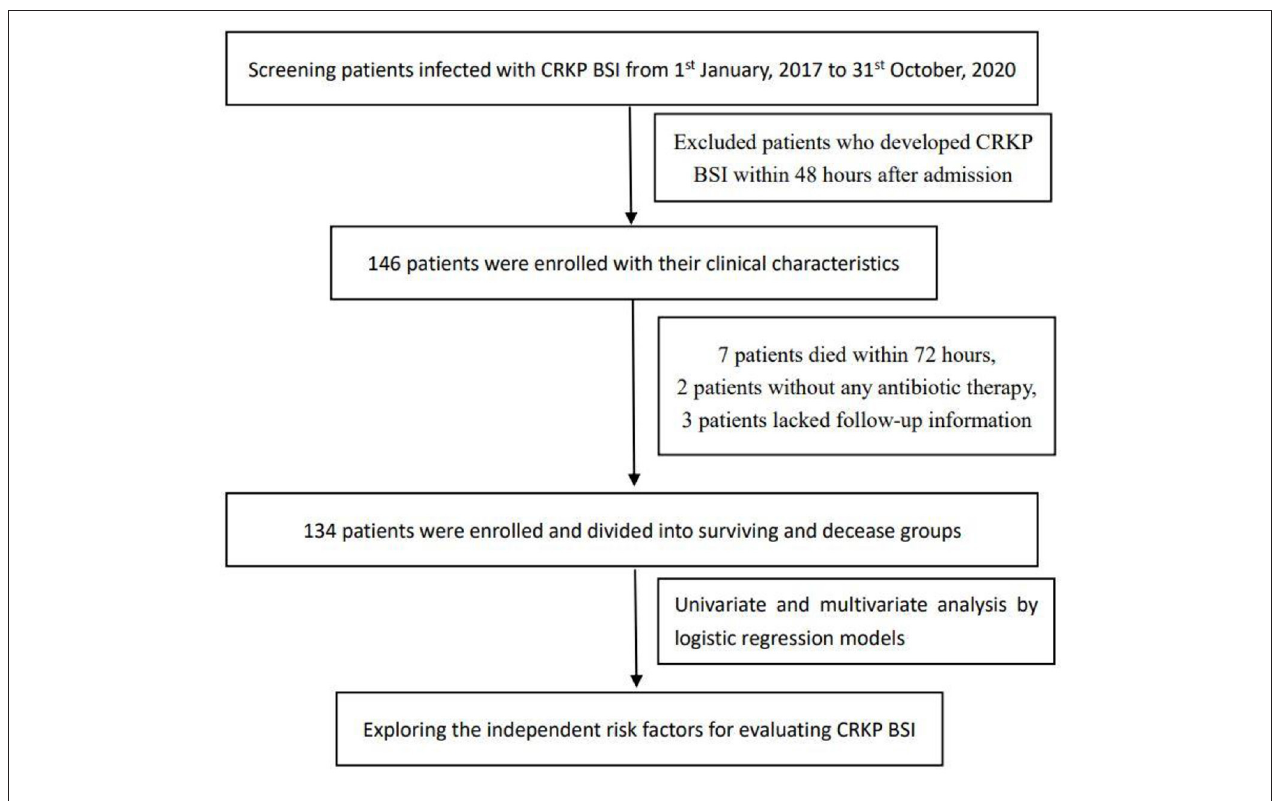
FIGURE 1 | Flowchart of the study